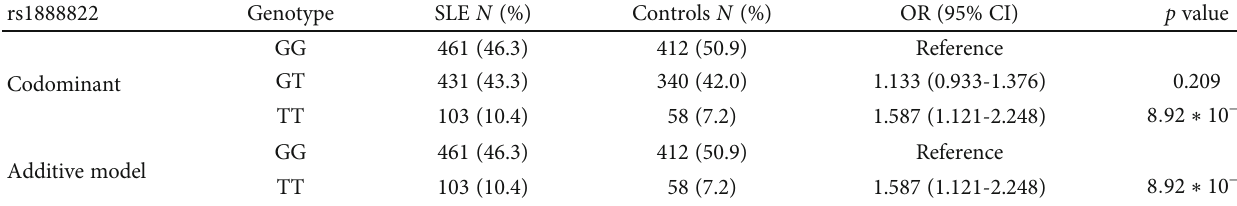
Table 2: Genotype frequency of SCUBE3 rs1888822 in SLE patients and healthy controls.